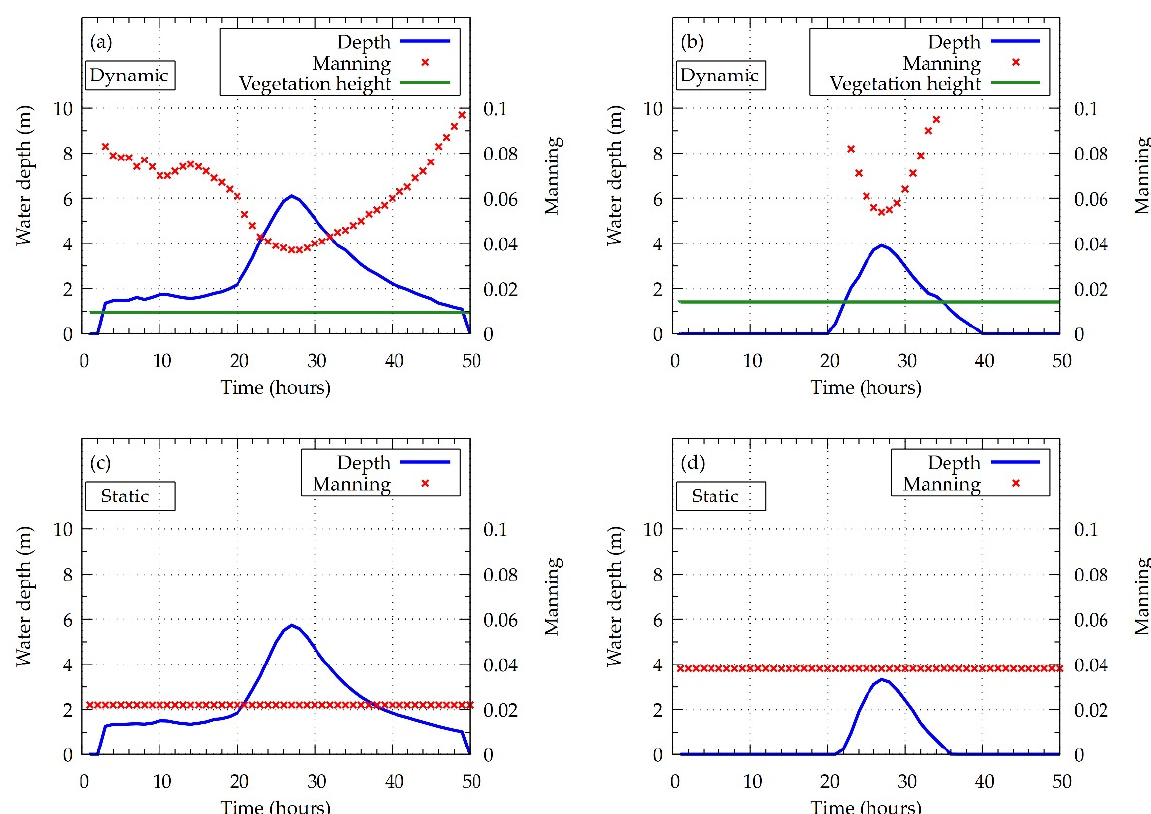
Figure 12. Pixel-level behavior of the Manning roughness coefficient estimation along the simulation time for: ( a ) the dynamic roughness model in September 2019 at point 1 from Figure 1c, ( b ) the dynamic roughness model in September 2019 at point 2 from Figure 1c, ( c ) the static roughness model at point 1 in Figure 1c, and ( d ) the static roughness model at point 2 in Figure 1c.